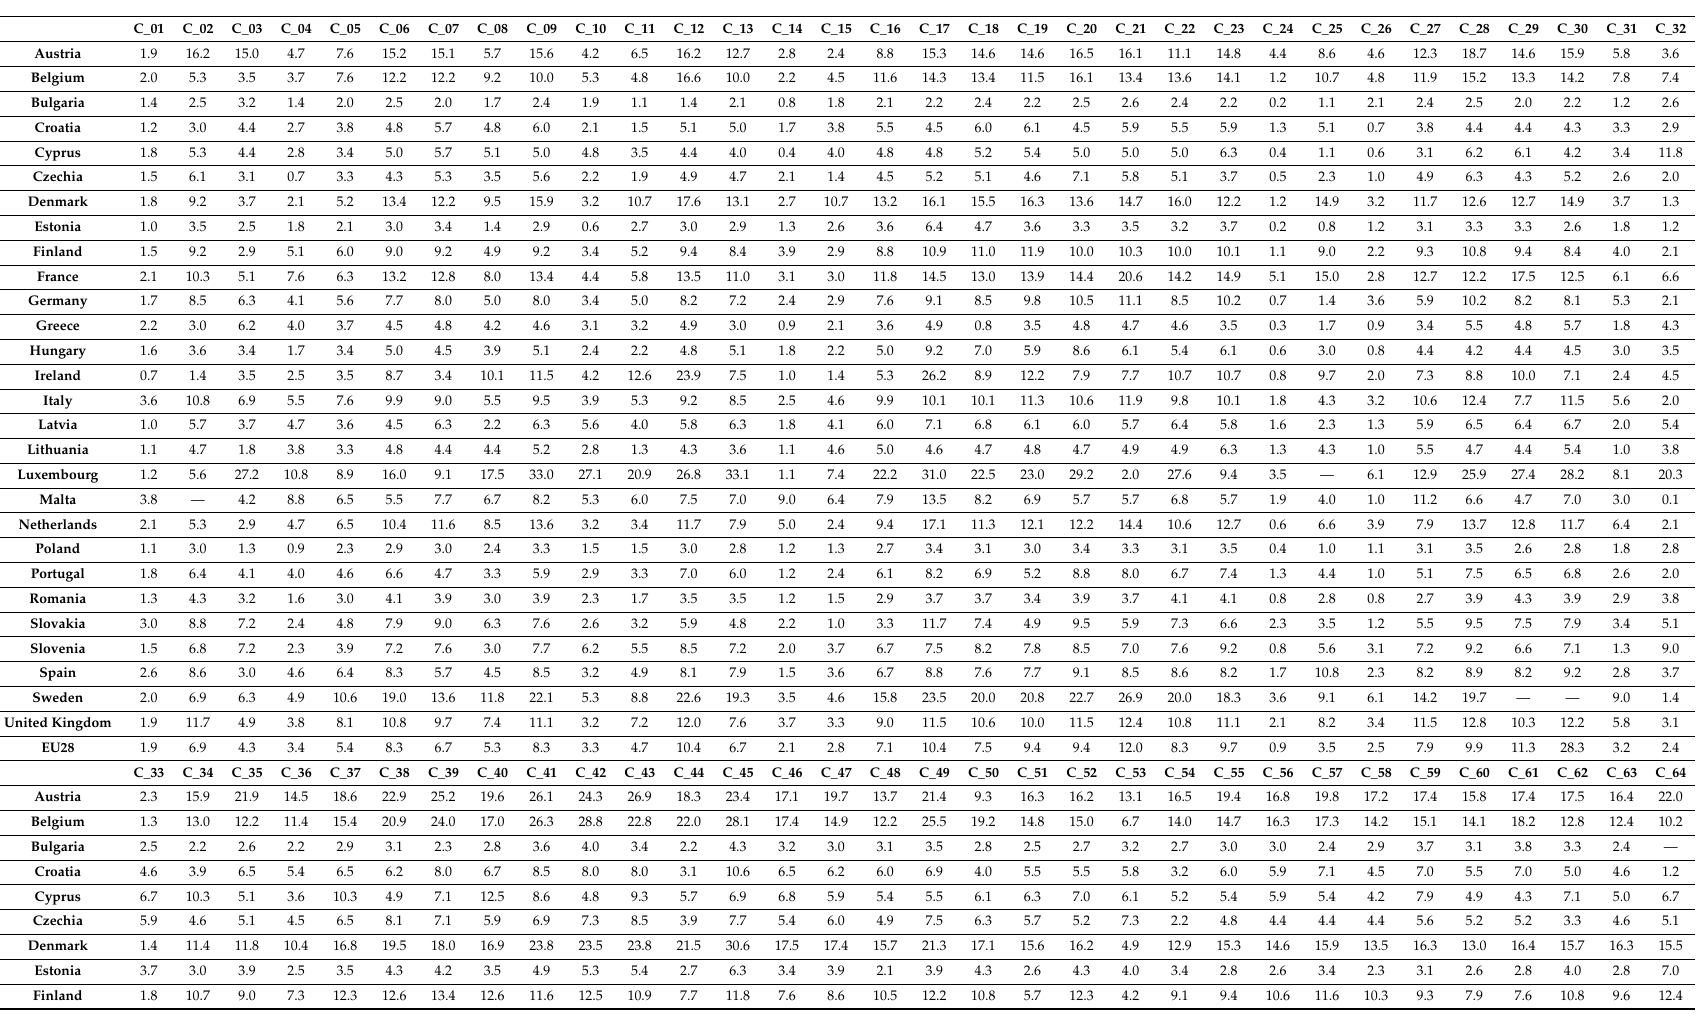
Table A5. Average output (millions of euros) reduction caused by a reduction of 1000 tonnes of GHG emissions through a reduction in demand (disaggregated